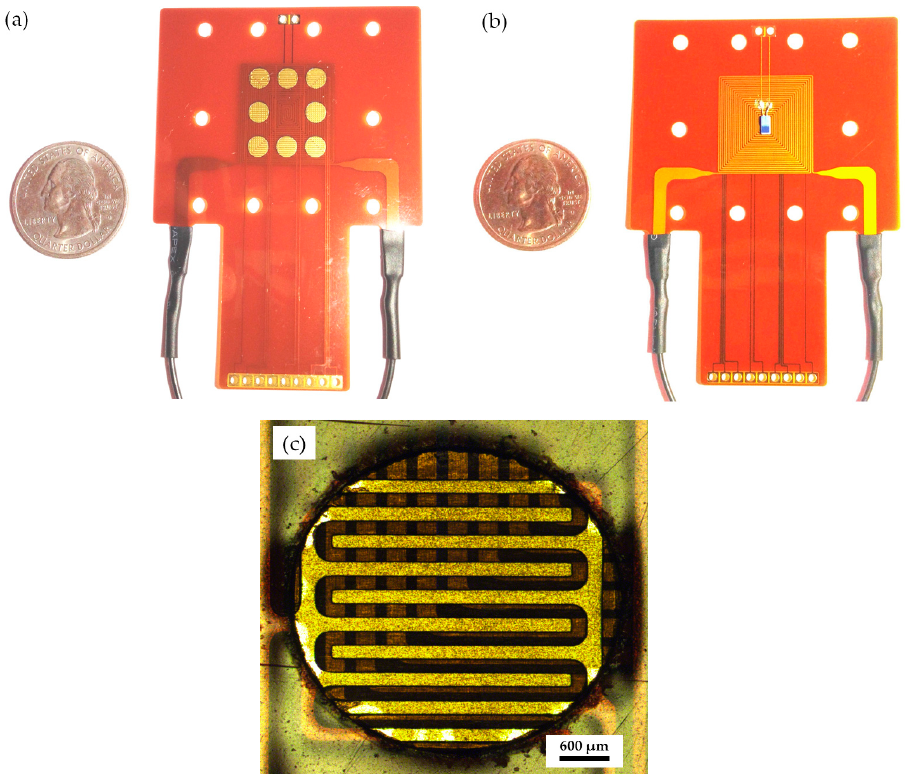
Figure 3. Configuration of flexible gas sensor array: ( a ) Front photograph of gas sensor array; ( b ) Reverse side photograph of heater embedded with RTD sensor; ( c ) Photograph of interdigitated electrodes.